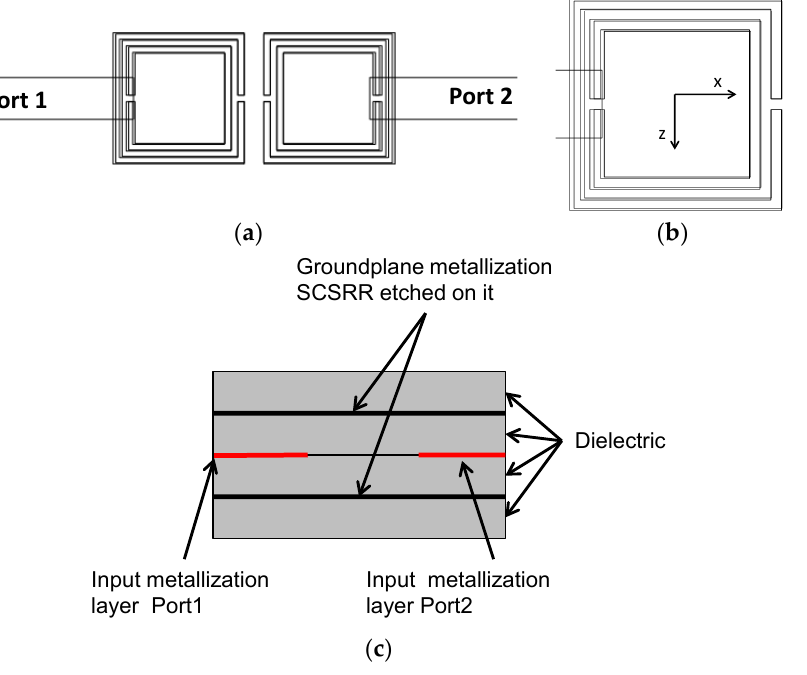
Figure 25. ( a ) Top view of the overlapped layer distribution of a multilayer stripline filter. ( b ) SCSRR zoom. ( c ) Front view of the layer distribution.